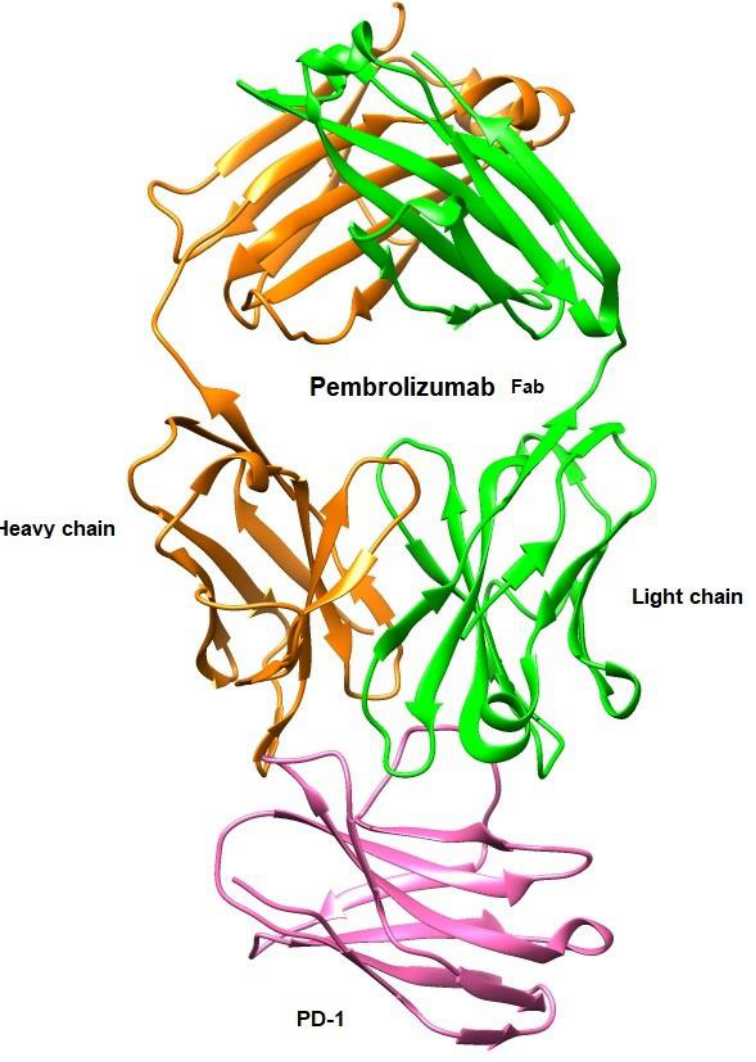
Figure 11. Structural representation of the antigen-binding fragment (Fab) of pembrolizumab (PDB ID: 5GGS) in complex with the extracellular domain of human PD-1 receptor using UCSF Chimera [58,97,98].